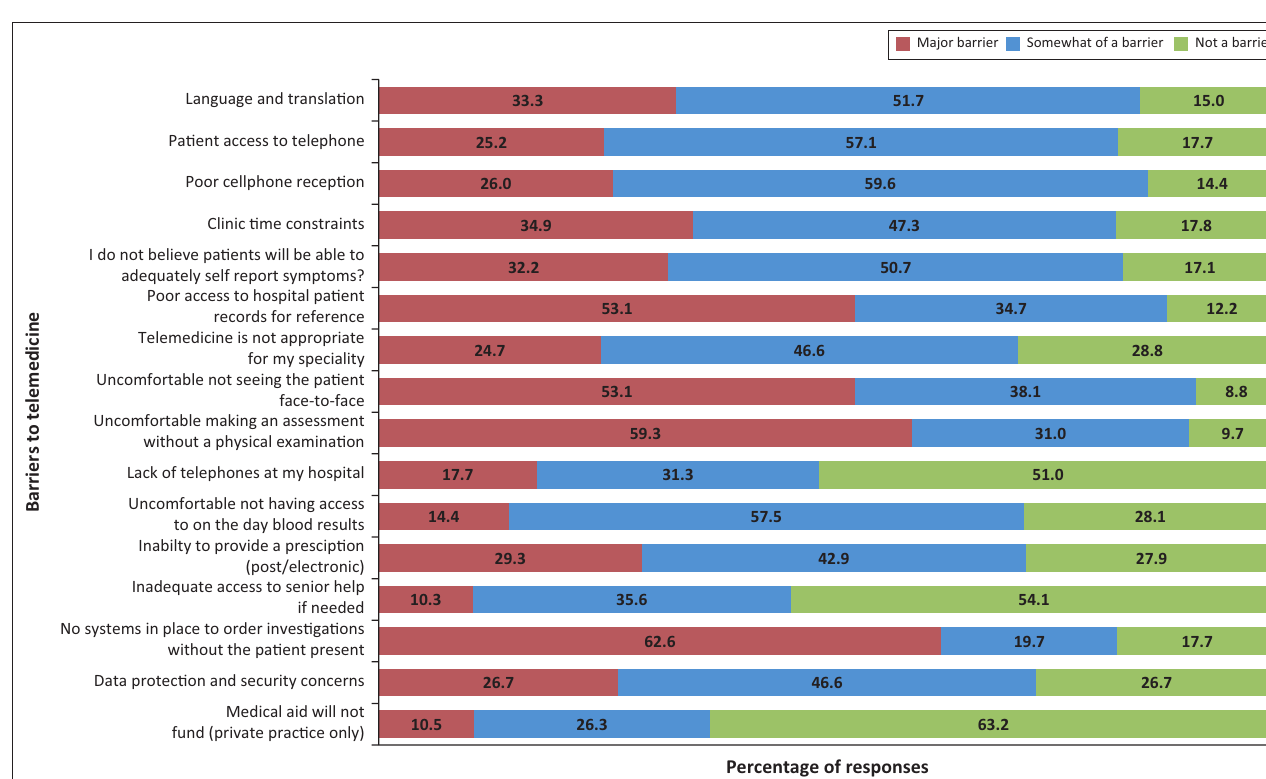
FIGURE 1 : Doctor perceived barriers as per responses.